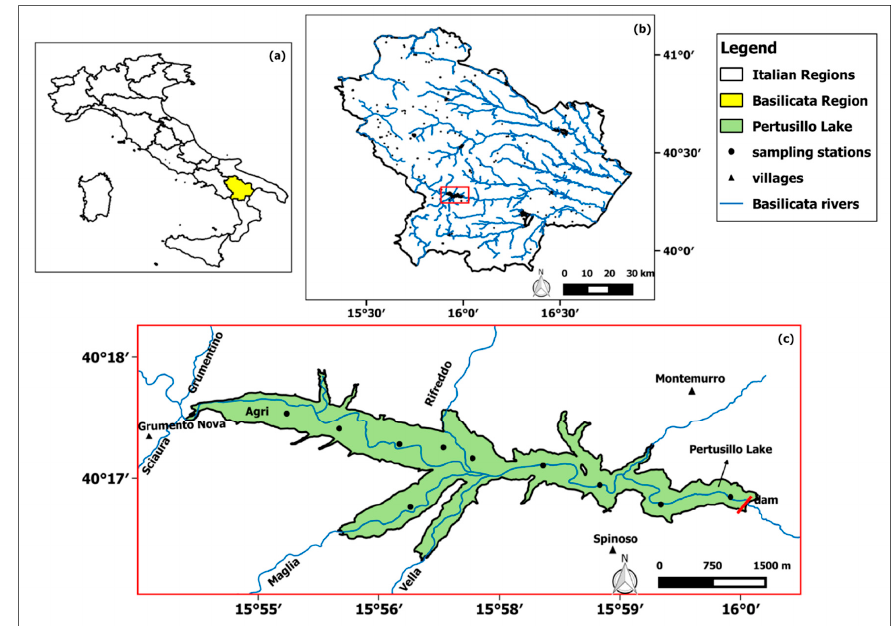
Figure 1. ( a ) Location (highlighted in yellow) of the Basilicata region within the Italian peninsula; ( b ) the Basilicata region’s hydrographic network; ( c ) magnification of the study area within the red box of ( b ). The main rivers and tributaries (blue lines) are depicted, as are the villages (black triangles) close to PL. The black dots within PL are the sampling stations planned for the measurement